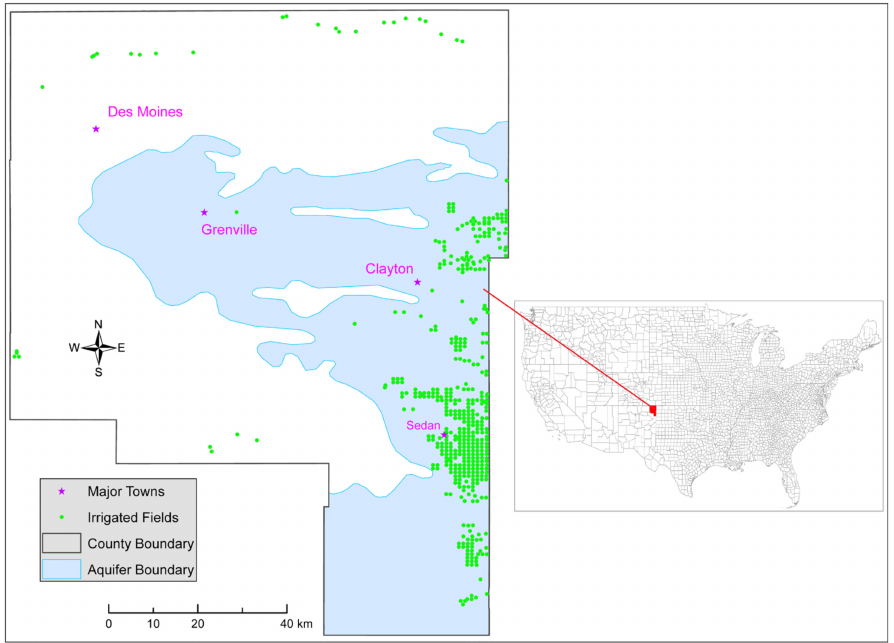
Figure 1. The High Plains (Ogallala) Aquifer and irrigated crop fields in Union County, New Mexico. Data Source: US Geological Survey, US Census, and Google Maps. Note: (1) A total of 472 circular irrigated fields are illustrated on the map. (2) The aquifer map was published in 2010 by the US Geological Survey (see https://pubs.usgs.gov/ds/543/ (accessed on 19 March